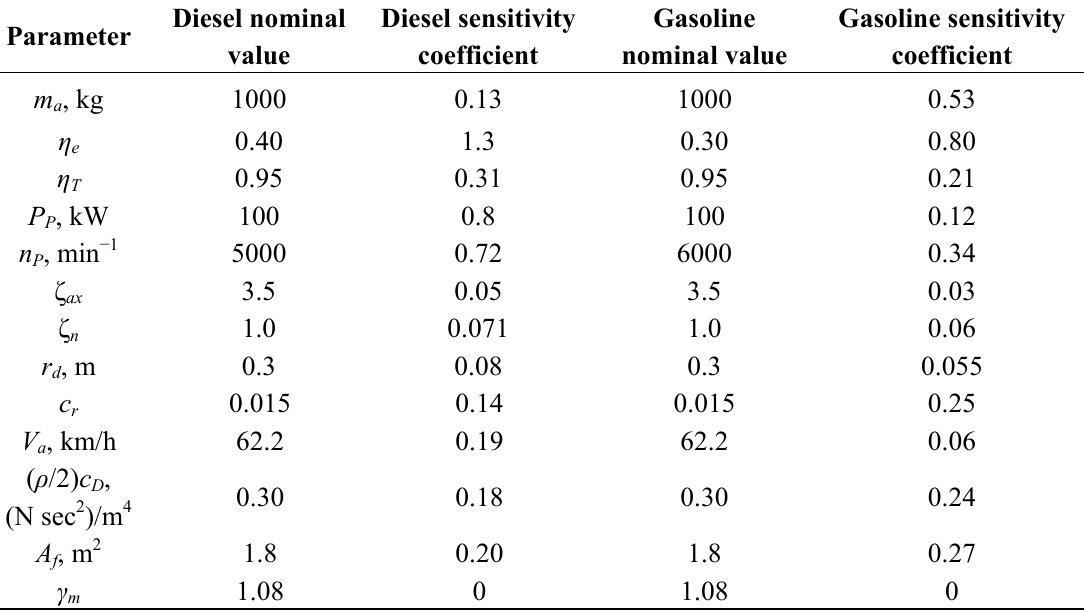
Table 4. Sensitivity coefficients of fuel consumption to various design